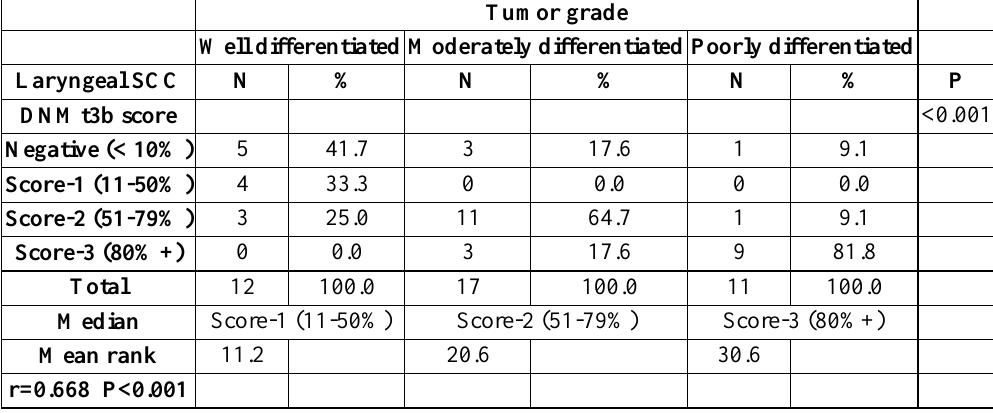
Table 5: The difference in median score category ofDNMT3B among the 3 tumor grades among cases with Laryngeal SCC. Tumor grade